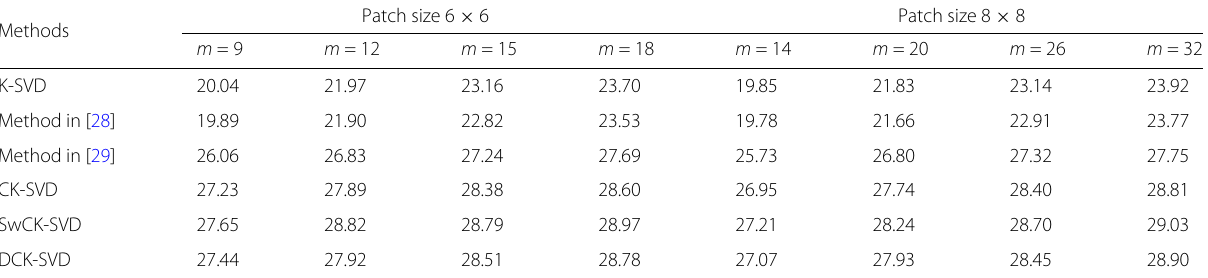
Table 2 Comparison of PSNR (dB) of reconstructed image “Elephant” with different number of measurements and different patch sizes